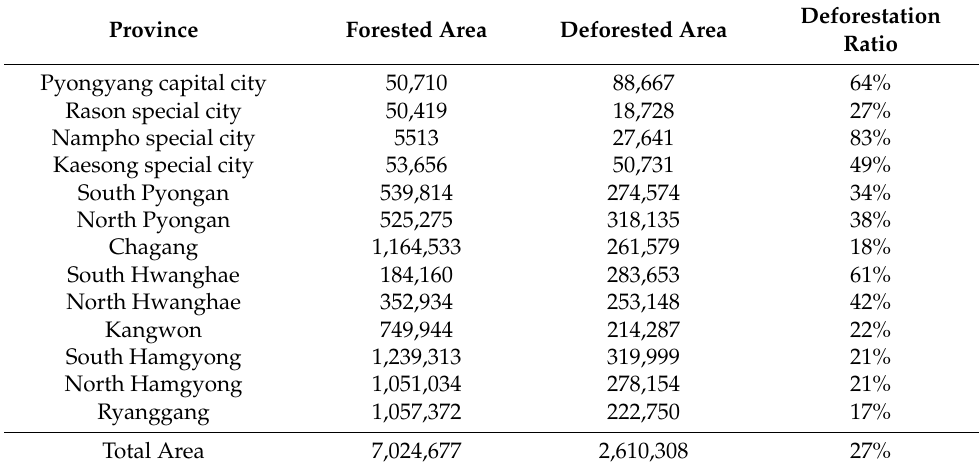
Table 3. Spatial distribution of classification results by